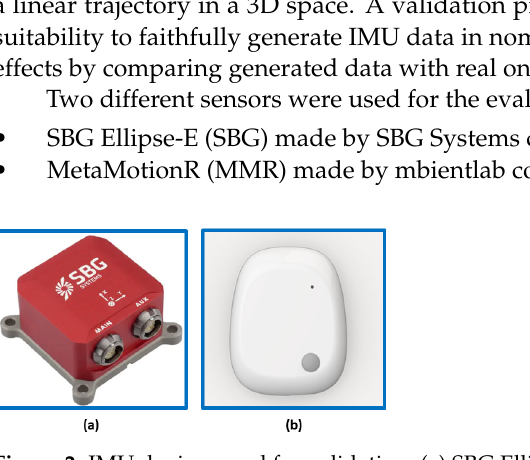
Figure 2. IMU devices used for validation: ( a ) SBG Ellipse-E; ( b ) MetaMotionR.